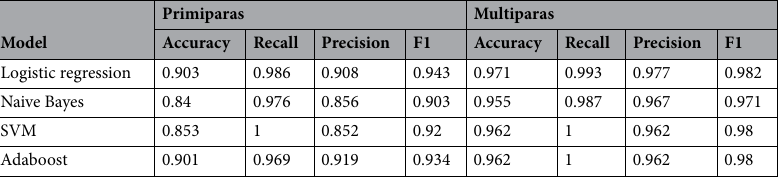
Table 3. Accuracy, precision, recall rate, and F1 value of the four models for predicting the outcome of induced labor.